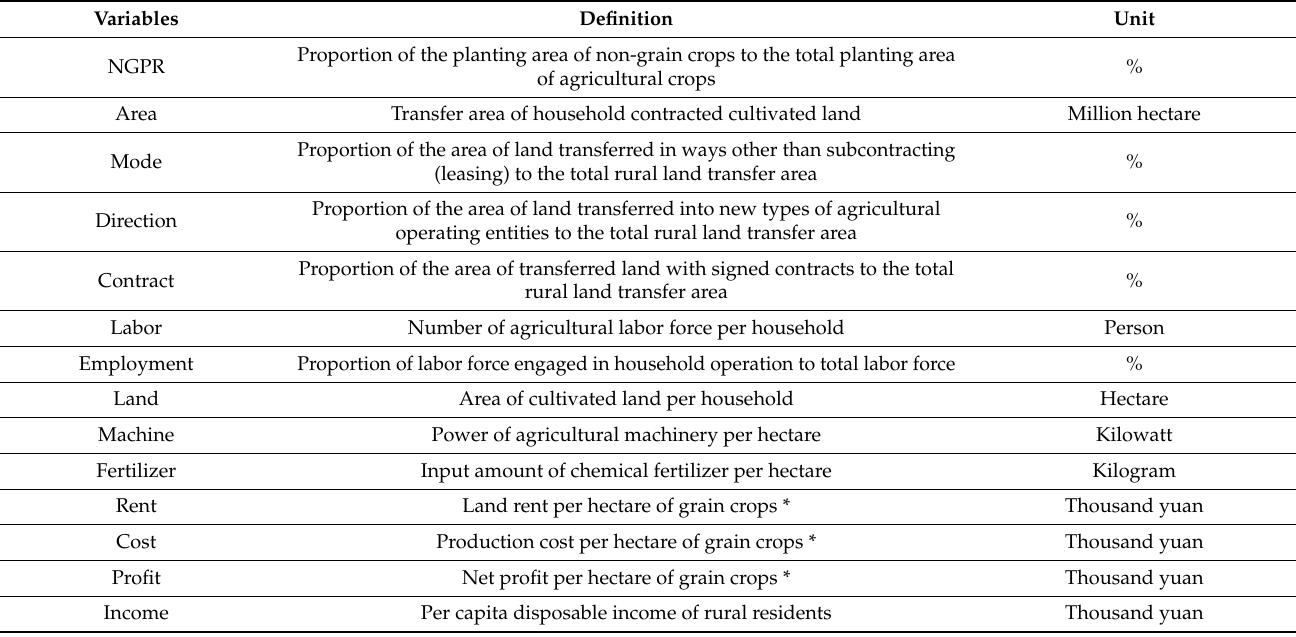
Table 1. Definition of each